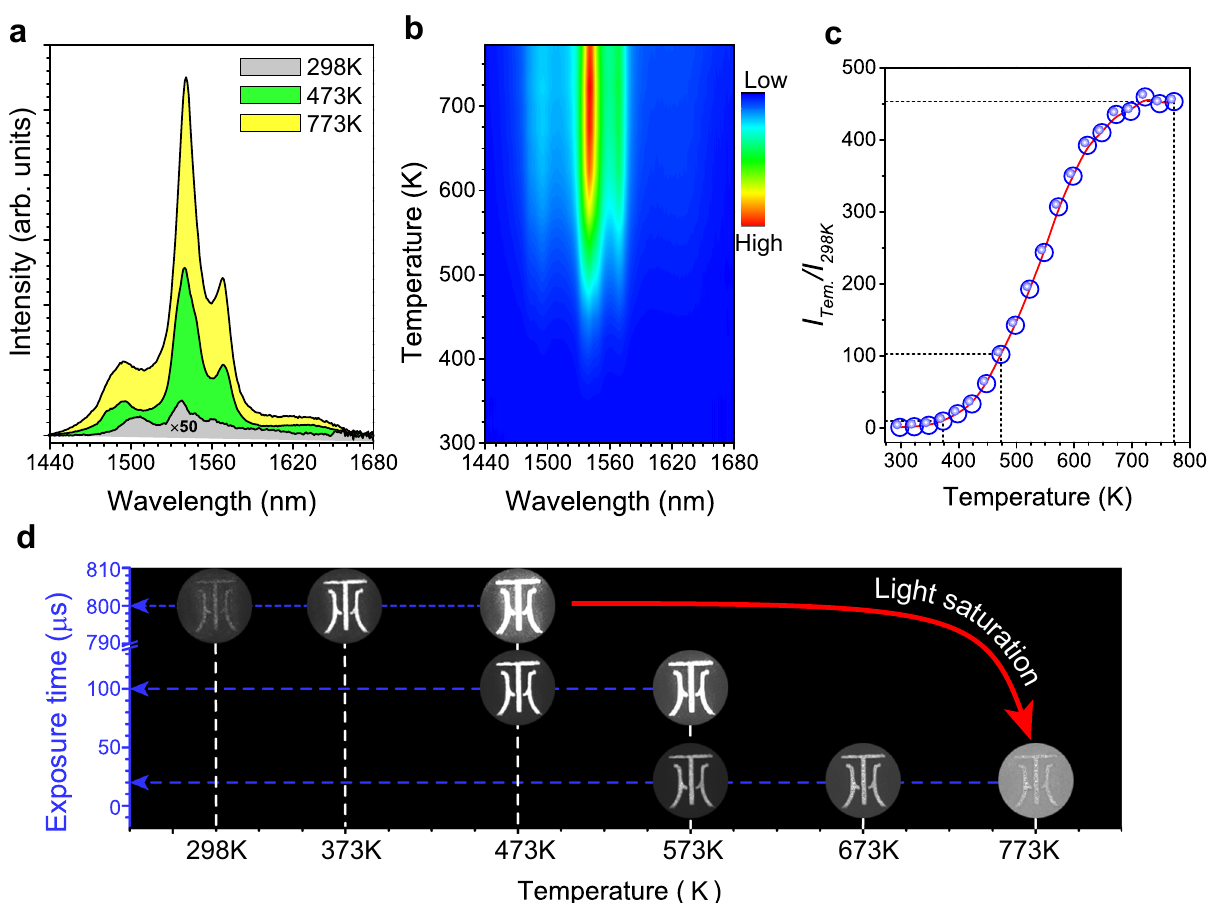
Fig. 4 Thermally enhanced downshifting emission. a DS emission spectra of Sc 2 (MoO 4 ) 3 :20%Yb/1%Er phosphor with different temperatures. b Two- dimensional DS emission topographical mapping with the temperature from 298 to 773 K. c Normalized DS emission intensity as a function of temperature. d Photographs of Sc 2 (MoO 4 ) 3 :20%Yb/1%Er at various temperatures by a NIR camera. To avoid interference of 980 nm laser, a 1250 nm fi lter was added in the front of the Photonic Science InGaAs camera. The red arrow represents decreasing exposure times to avoid light